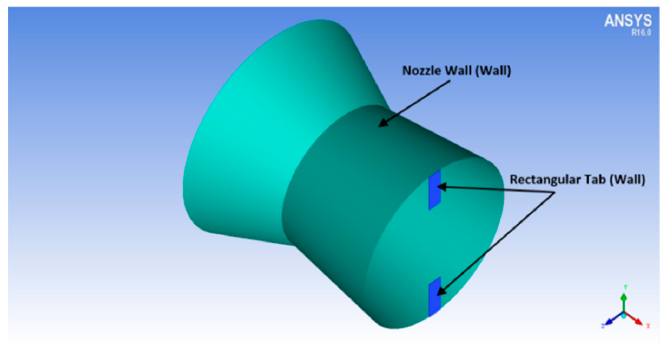
Figure 5. Nozzle inlet as pressure inlet.